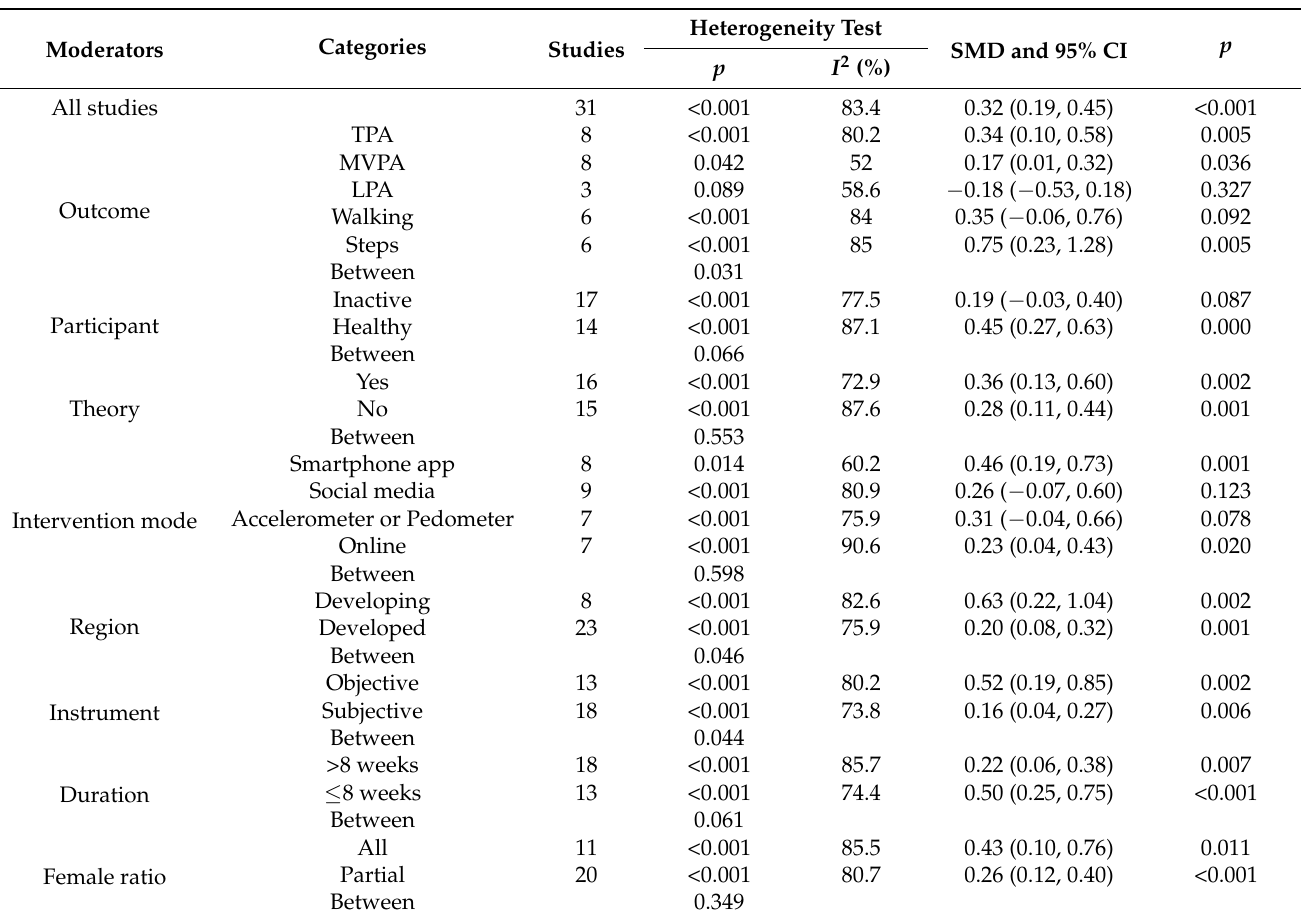
Table 1. Subgroup analyses of the effects of e-health interventions on PA at